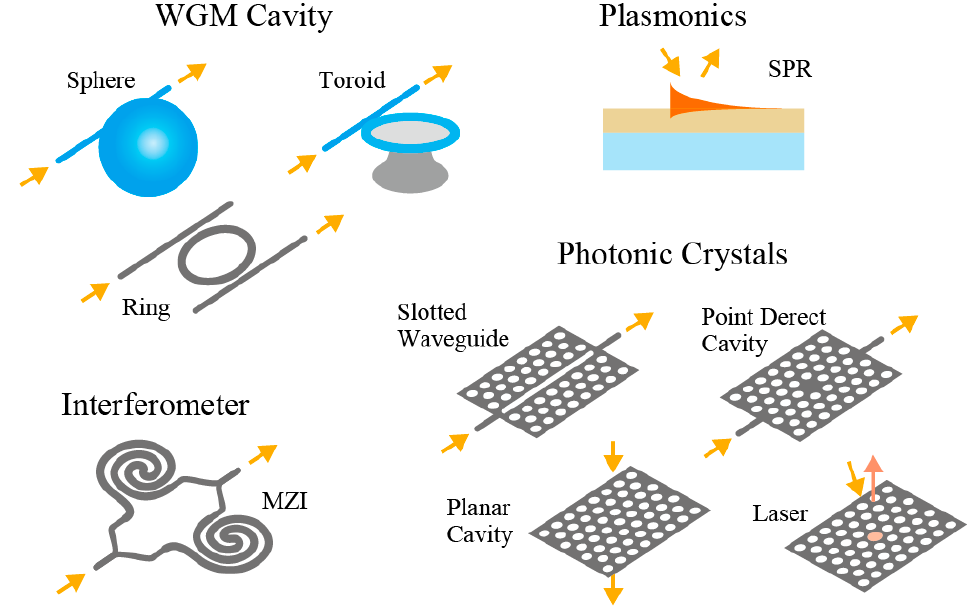
Figure 1. Passive microcavities and nanolasers used for sensing applications.